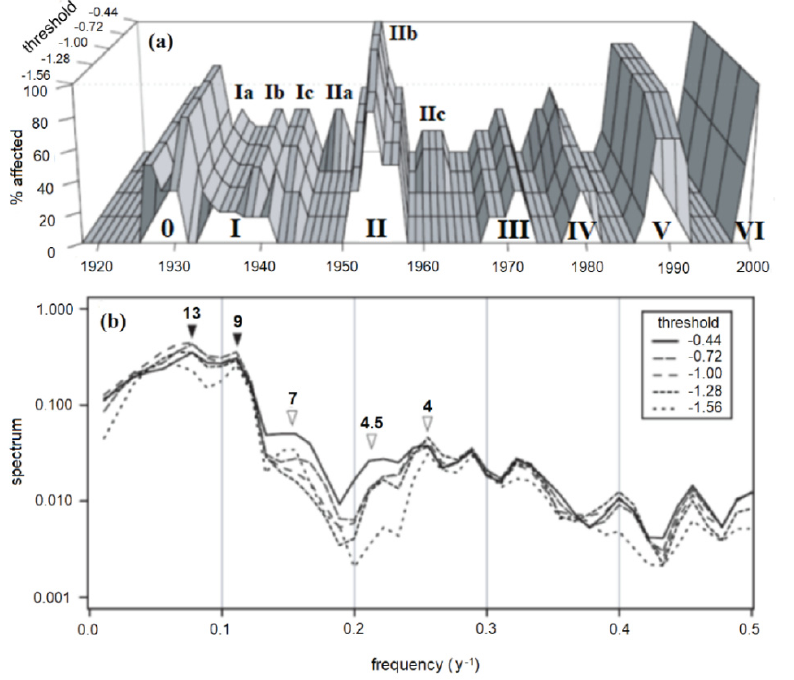
Figure 6. Minnesota FTC outbreaks, reconstructed by filtering KSF and CVSF ring-width chronologies by using the program OUTBREAK, with the “maximum growth reduction threshold” parameter varying systematically from − 1.56 to − 0.44 standard deviations. ( a ) Percentage of chronologies exhibiting a “significant” growth reduction for a given year. Roman numerals indicate major outbreak cycles, as in Figure 2. Letter codes a-c represent more localized pulses associated with each outbreak cycle. ( b ) Spectra of reconstructed outbreaks in ( a ). Arrows indicate major (dark) and minor (light) periodic components of variability.